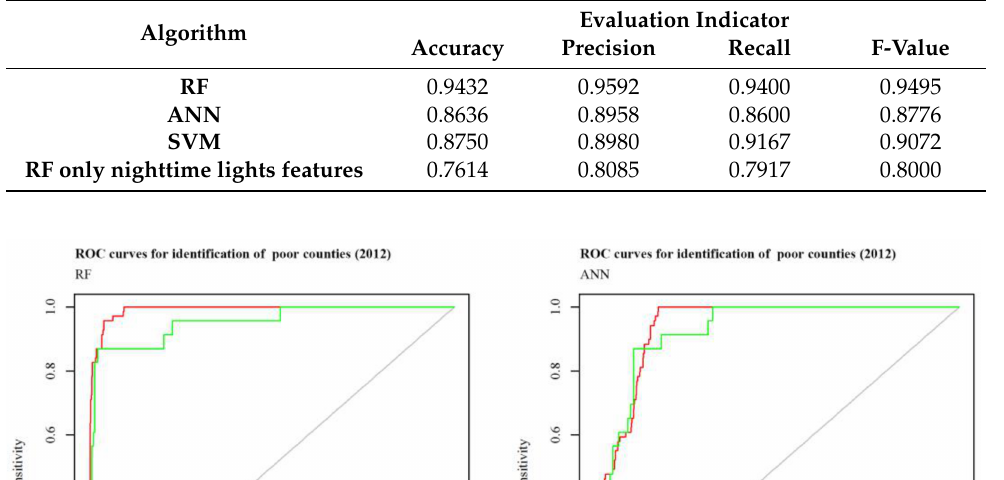
Table 2. Evaluation indicators in poverty identification by the typical algorithms.